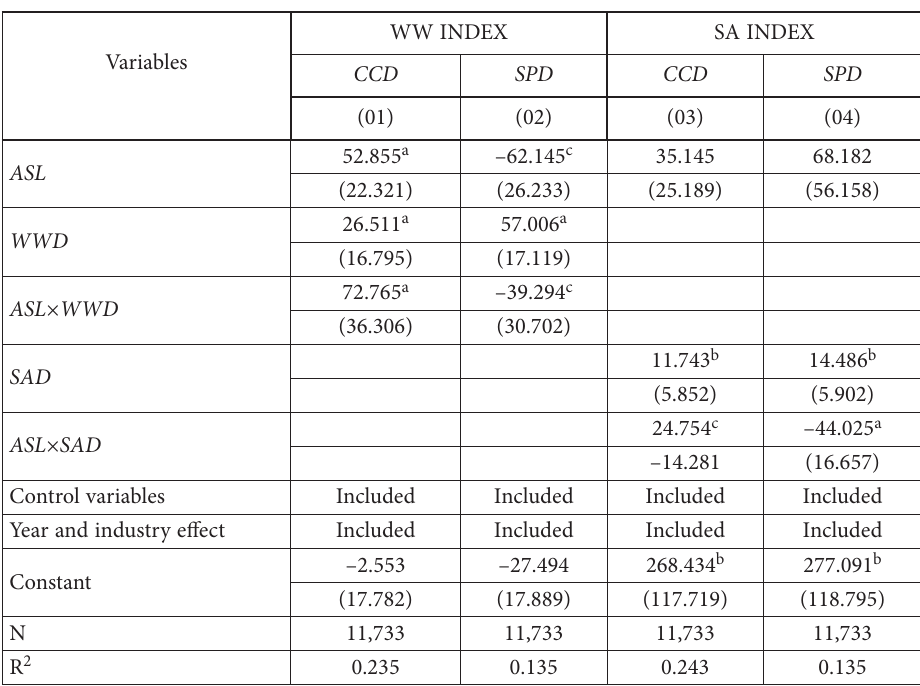
Table 7. Financial flexibility (debt